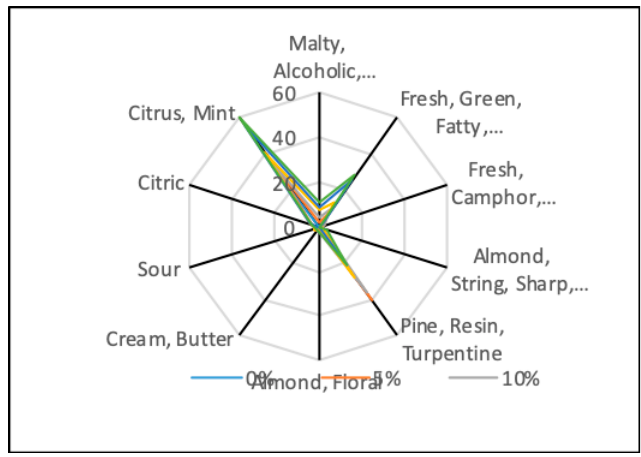
Figure 2. Aroma profile of enriched biscuits with spent malt rootlets in different concentrations (0–25%).